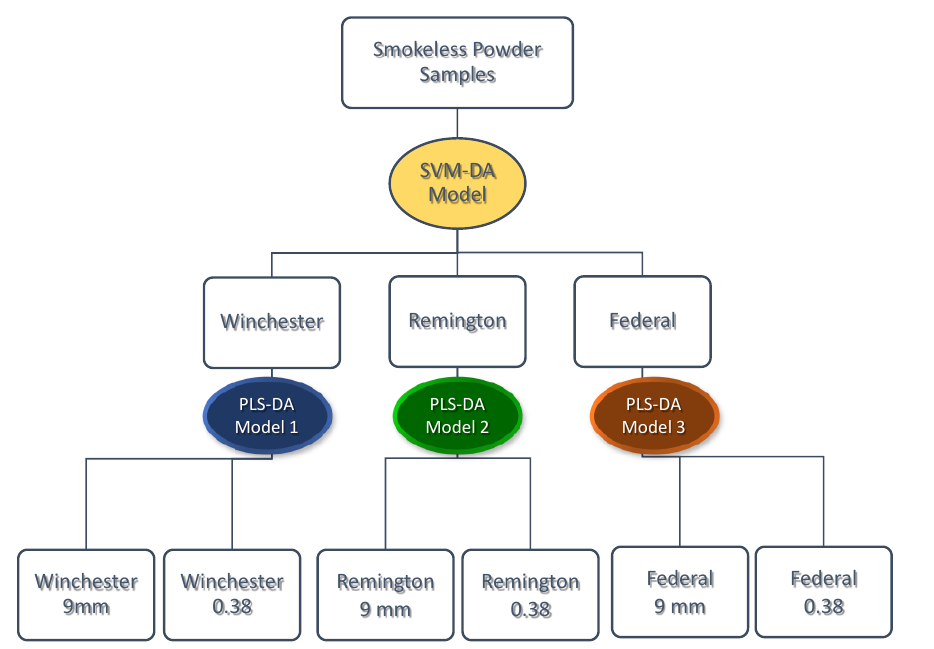
Figure 1. Hierarchical modeling scheme.